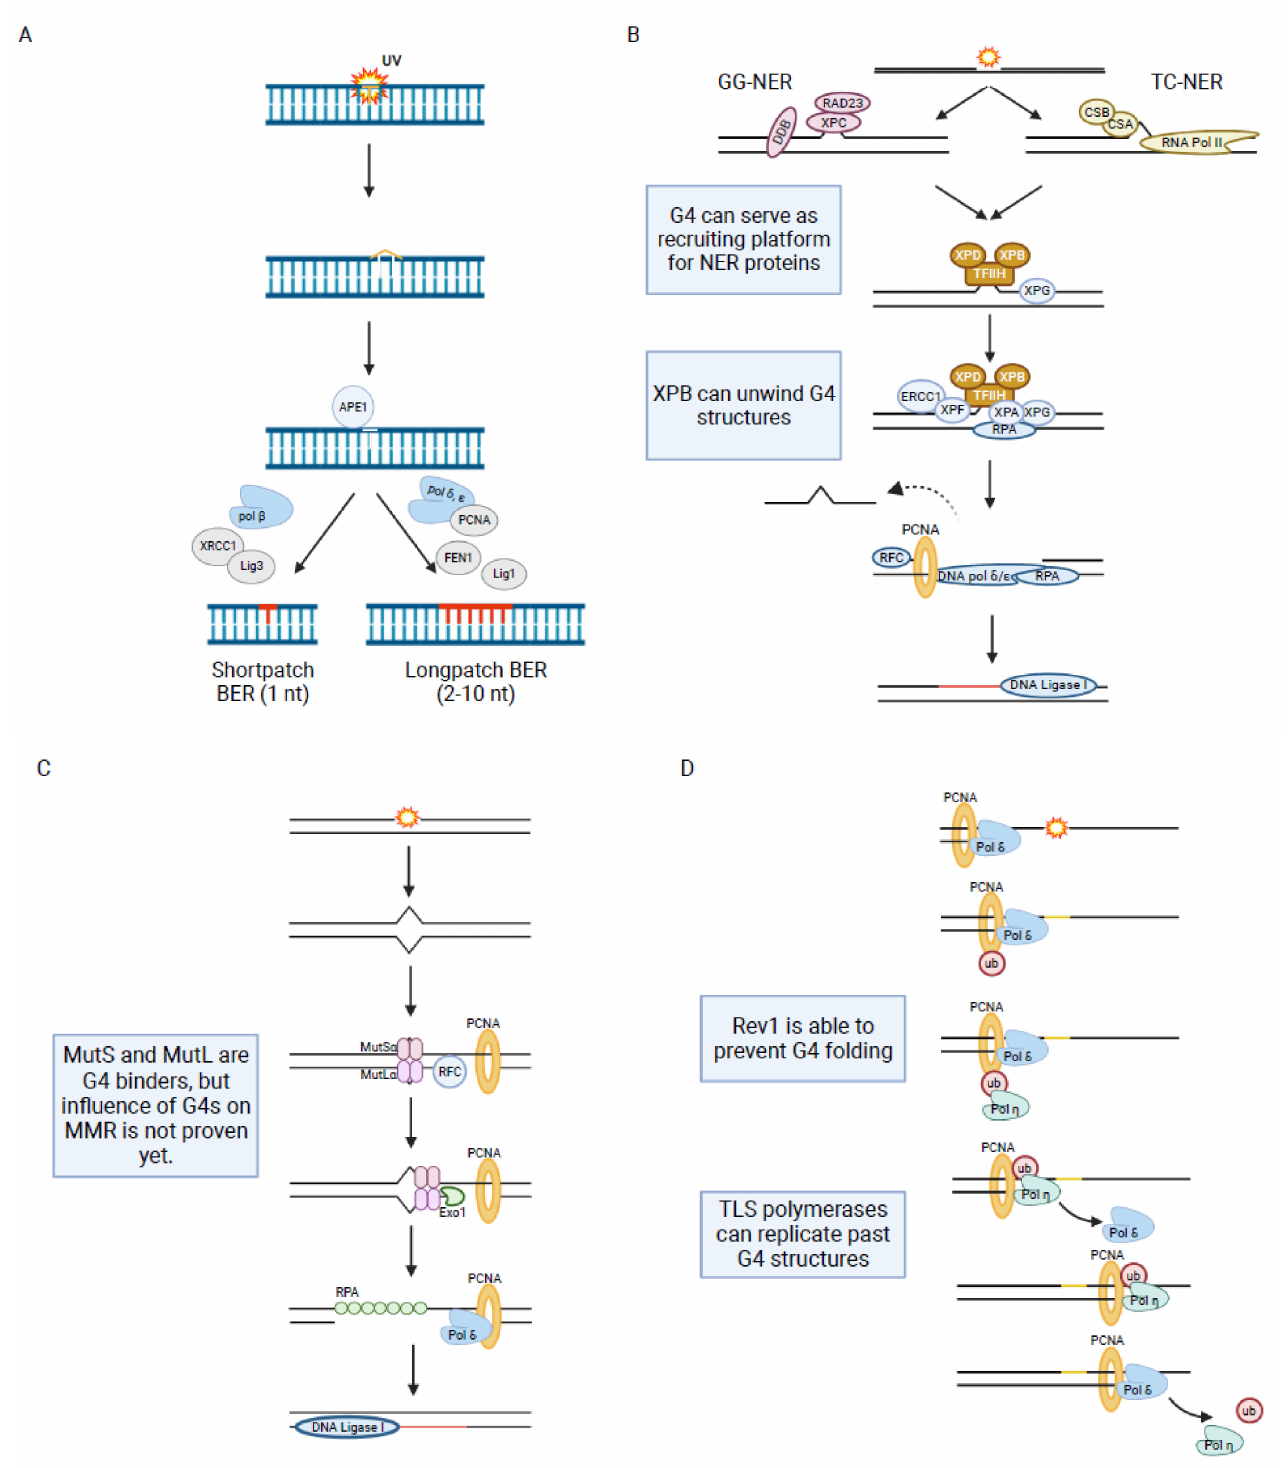
Figure 3. Schematic illustration of post-replicative DDR and translesion synthesis. ( A ) Cartoon of essential steps and proteins during BER. Relevance of G4 formation during initiation and lesion processing are highlighted in the box. ( B ) Cartoon of essential steps and proteins during NER. Relevance of G4 formation is indicated in the box. ( C ) Cartoon of essential steps and proteins during MMR. Relevance of G4 formation is indicated in the box. ( D ) Cartoon of essential steps and proteins during TLS. Relevance of G4 formation during initiation and lesion processing is highlighted in the box. Figure was created using